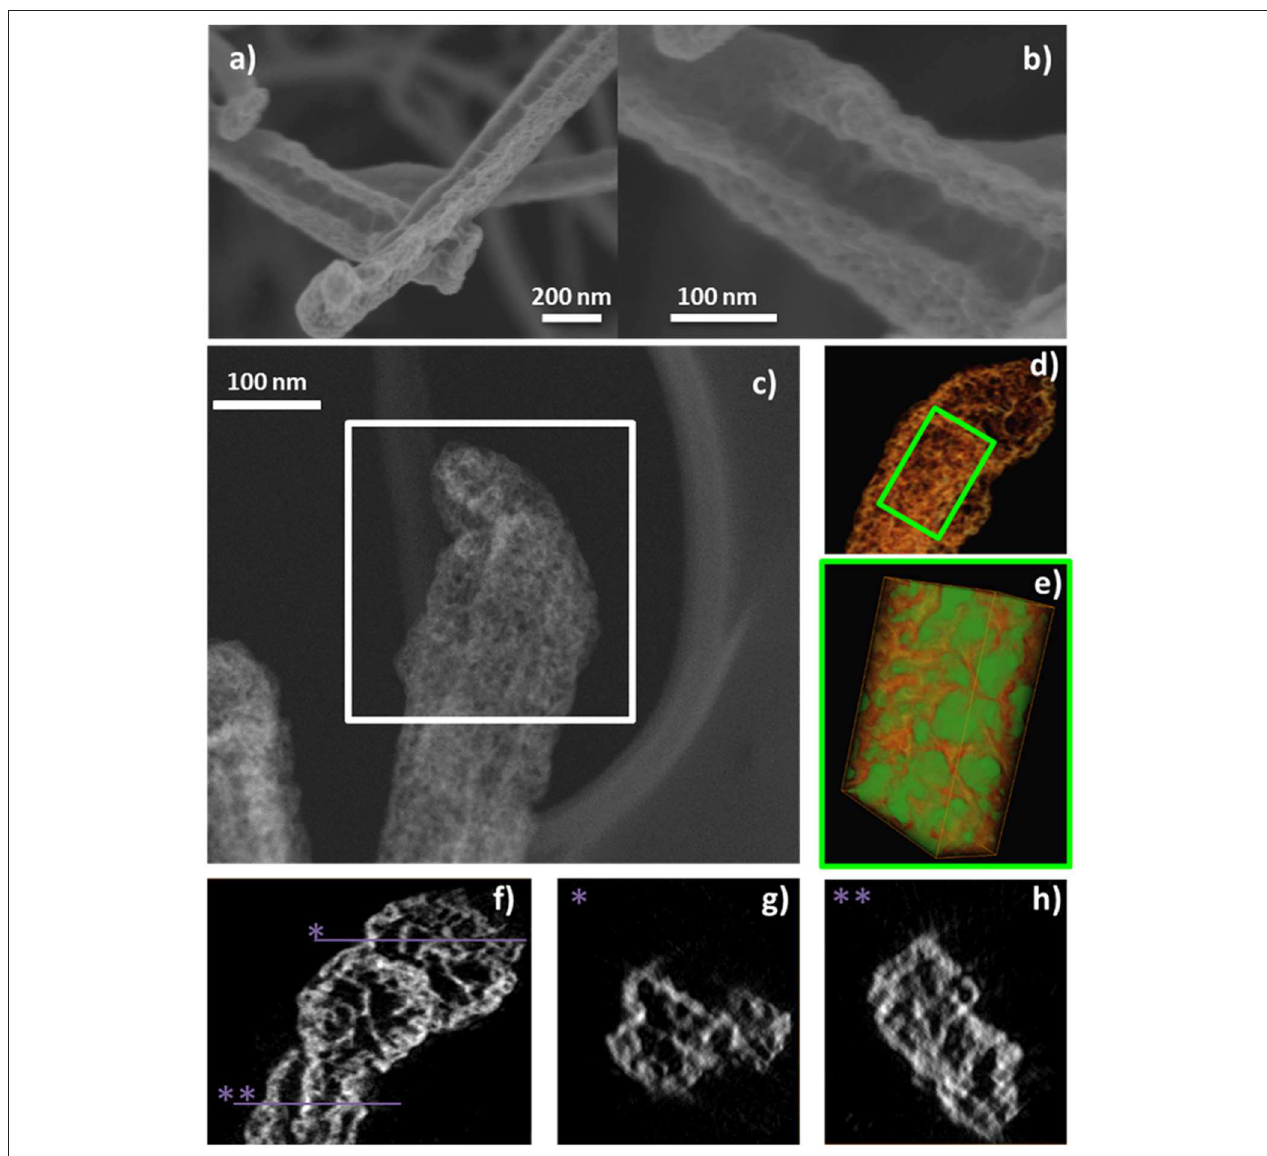
FIGURE 8 | (a,b) SEM micrographs of an @TiClPc RPAVD-O 2 -SPE nanotube, (c) HAADF-STEM image at − 60 ◦ of an isolated nanotube, selected for the electron tomography experiment. (d) Voxel rendering of the 3D reconstruction. (e) A subvolume was selected [inset in (d) ] for the segmentation of the pores (displayed in green) and the porosity estimation. (f) Is an xy slice through the volume. (g,h) Are xz slices at the y positions indicated in (f)